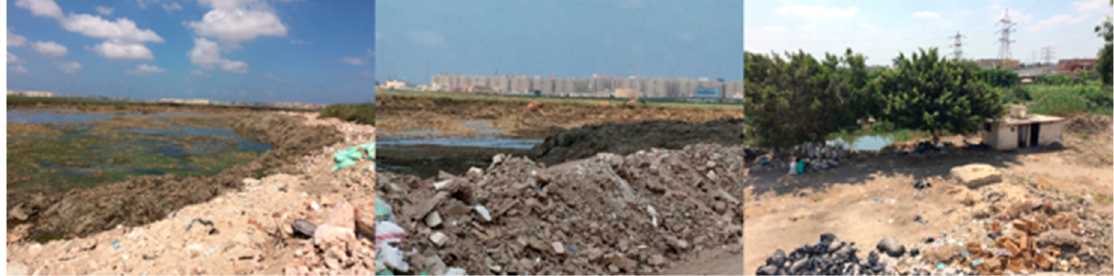
Figure 4. The Lake Mariout and Umum drainage. Source: Author. Legend: The lake is seriously polluted by different kinds of solid waste, as well as wastewater. It also contains high level of eutrophication ( left ); the government is implementing cleaning work by excavators ( middle ); residents living adjacent to the drainage and garbage heaps ( right ). Location: 31 ◦ 09 (cid:48) 18.2 (cid:48)(cid:48) N 29 ◦ 55 (cid:48) 26.6 (cid:48)(cid:48) E ( left and middle ) and 31 ◦ 09 (cid:48) 52.5 (cid:48)(cid:48) N 29 ◦ 59 (cid:48) 40.8 (cid:48)(cid:48) E ( right